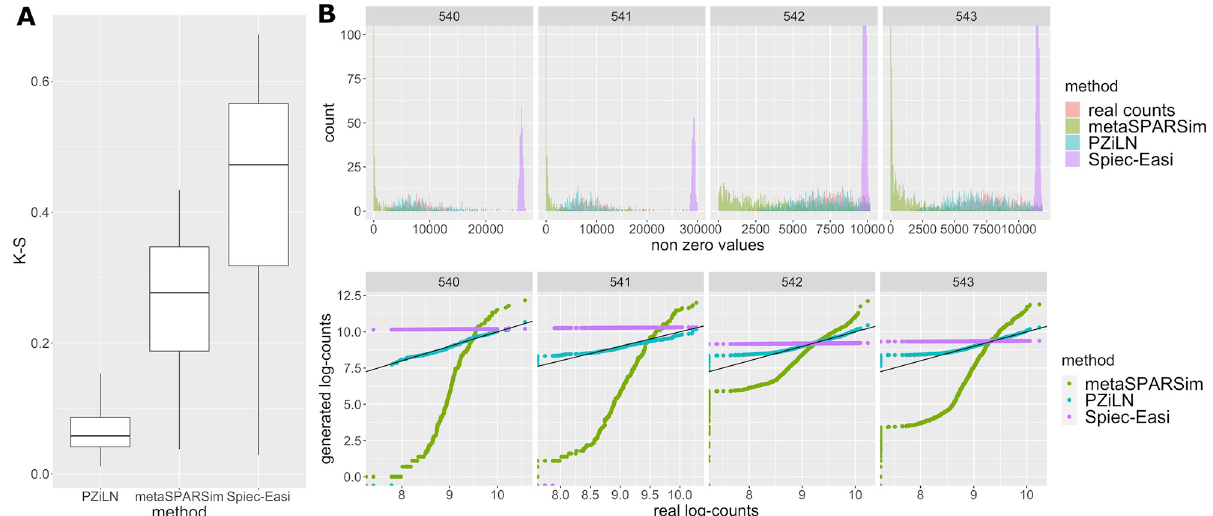
Fig 1. (A) Global feature by feature difference between the real (LifeLines-Deep cohort) and simulated counts measured by Kolmogorov-Smirnov statistics. (B) Top: histograms showing real and simulated count data. Real counts obtained from shotgun sequencing the microbiomes of the LifeLines- Deep cohort are shown in red; green, purple and blue represent synthetic counts generated respectively by metaSPARSim [28], spiec-easi [23] and our model (Poisson Zero Inflated Log Normal). The different panels show results for different randomly selected taxa. Down: quantile-quantile (QQ)-plots showing the logarithm of real counts vs the logarithm of synthetic